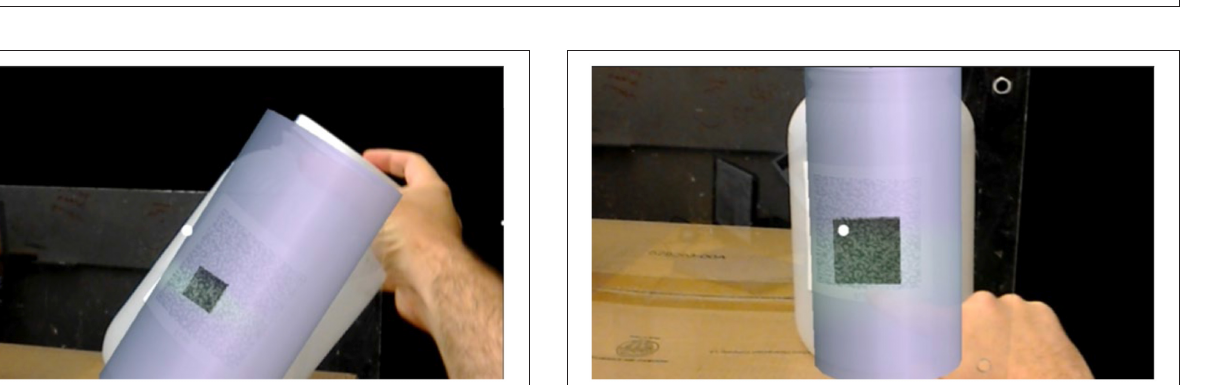
Frontiers in Built Environment |